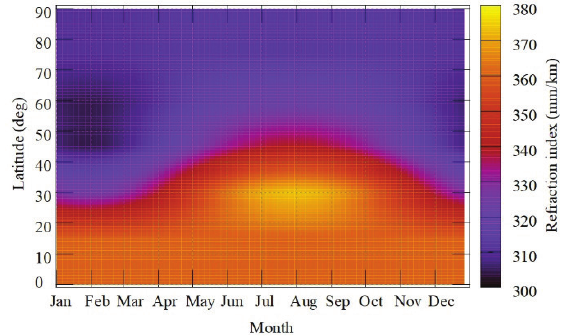
Figure 6. Simulation of the troposphere refraction index